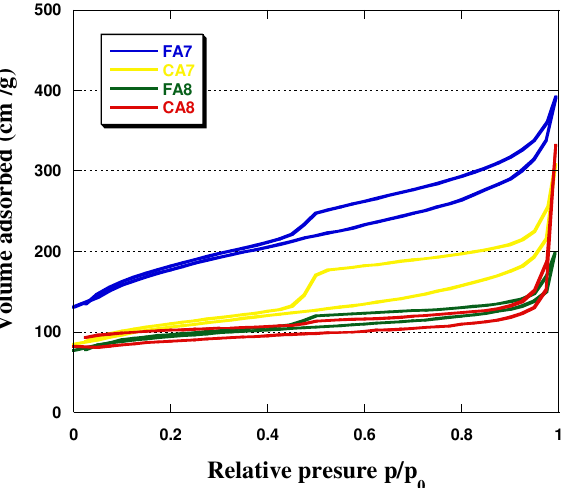
Figure 1. Pore size distribution of samples obtained.